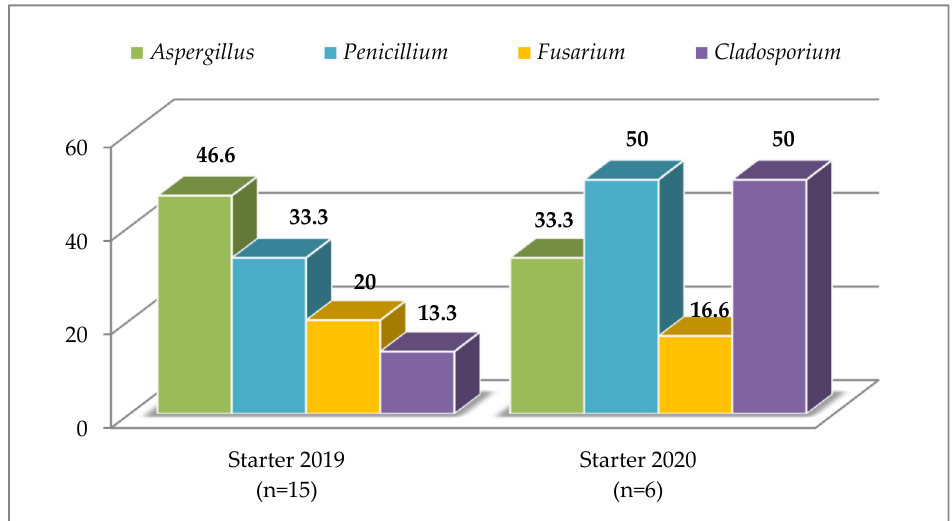
Figure 3. Proportion (%) of potentially toxigenic fungal genera in positive starter compound feed samples (n—number of positive samples).